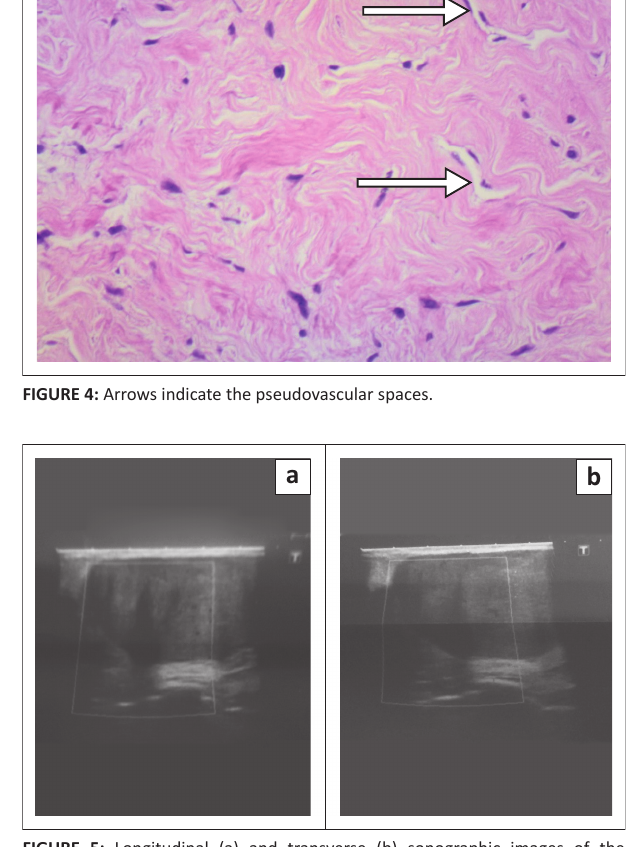
FIGURE 5: Longitudinal (a) and transverse (b) sonographic images of the predominantly isoechoic, palpable lump.